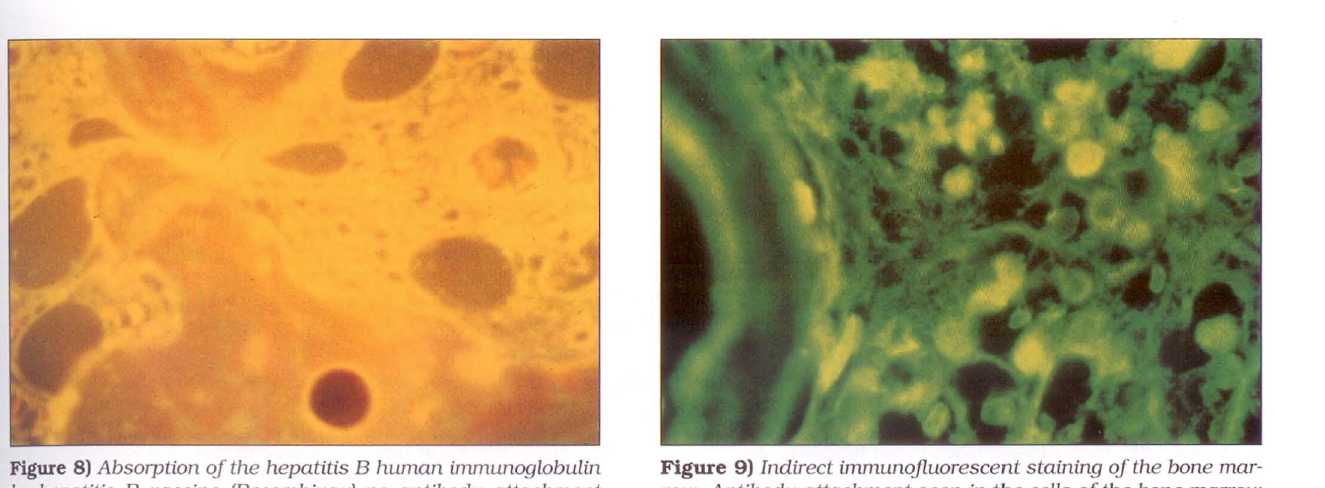
Figure 9) Indirect immunofluorescent staining of the bone mar row. Antibody attachment seen in the cells of the bone marrow taken during autopsy. Magnification x264